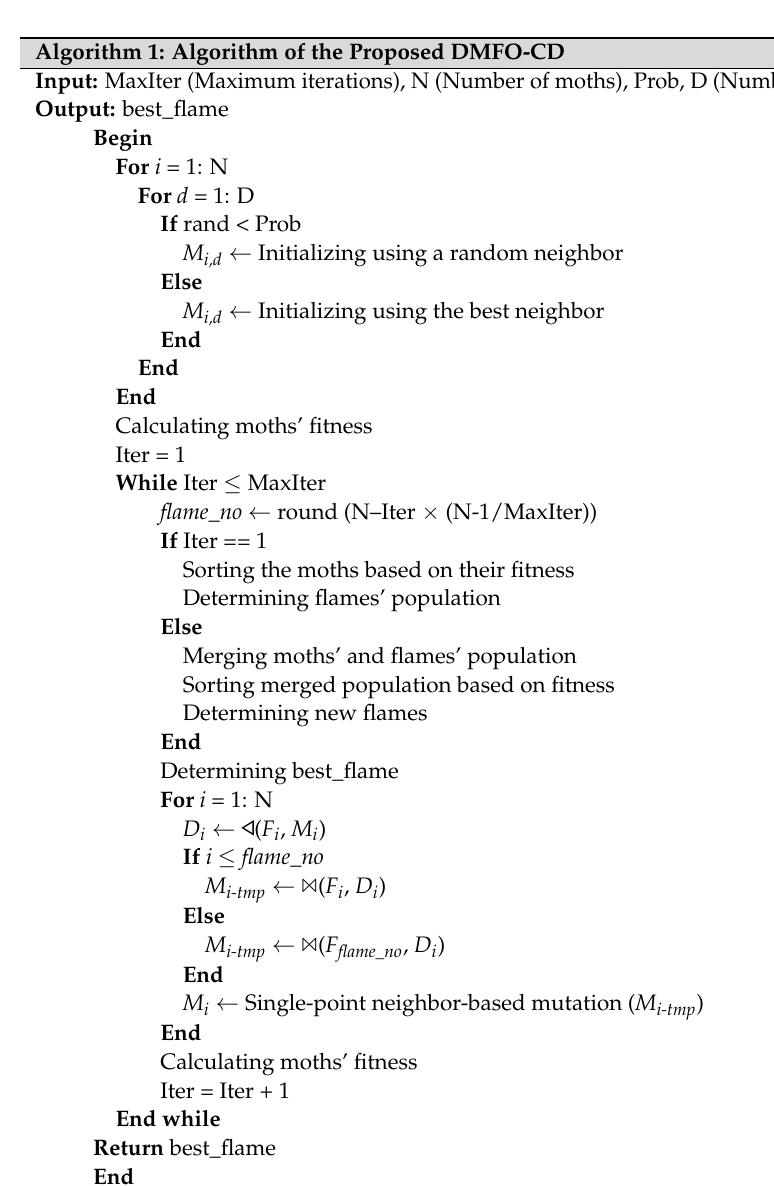
Algorithm 1: Algorithm of the Proposed